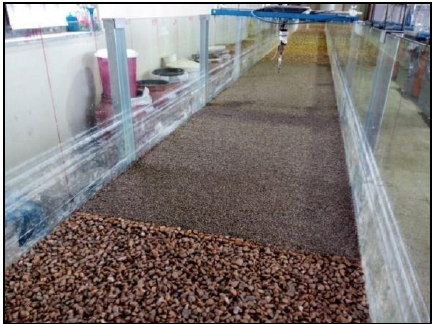
Figure 4. A view of the sand-bed section with coarse particles upstream and downstream.